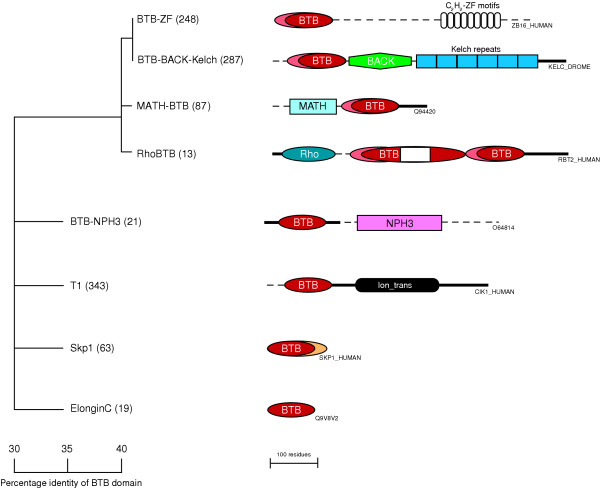
BTB sequence clusters and protein architectures. Family-specific amino- and carboxy-terminal extensions to the core BTB fold are indicated. Regions with no predicted secondary structure are indicated by dashed lines, and ordered regions are indicated with either domain notations or thick solid lines. The Uniprot code for a representative protein is indicated. Clustering by BLASTCLUST was based on the average pairwise sequence identity for all BTB domain sequences from our database, except for the RhoBTB proteins, where only the carboxy-terminal BTB domain was used. Domain names are from Pfam [44].